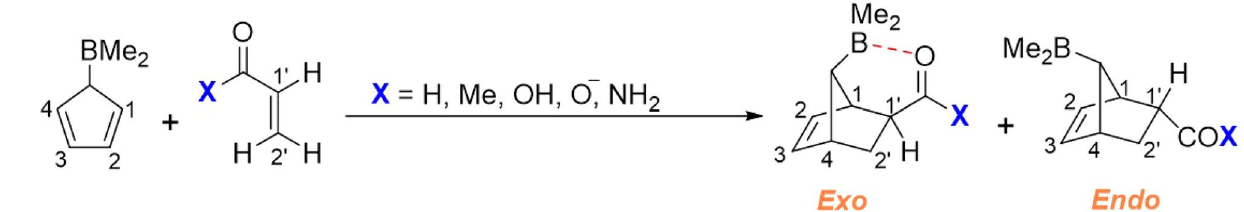
Figure 4. DA reaction of cyclopenta-2,4-dien-1-yldimethylborane and α , β -unsaturated carbonyl compounds. The red dashed line represents the LAB